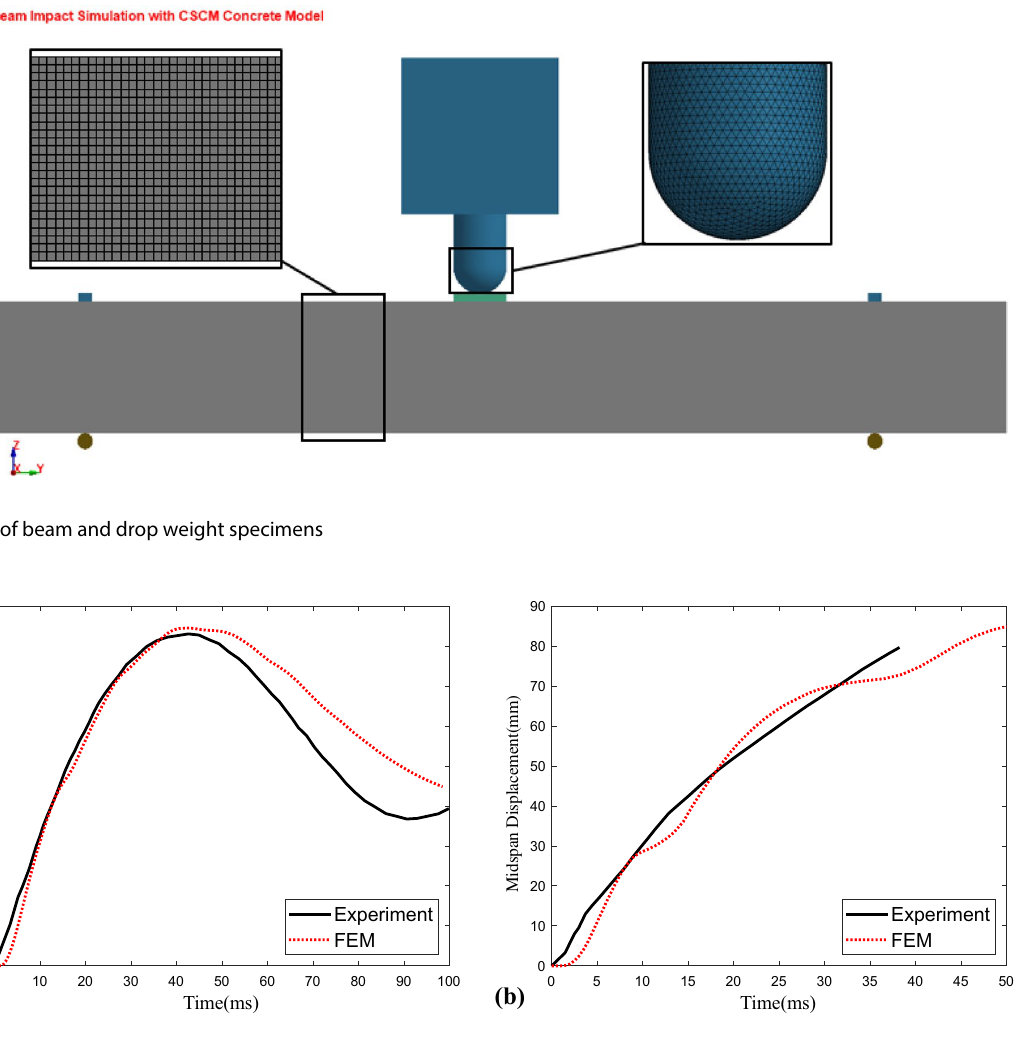
Fig. 5 Midspan deflection: a B-1700-4.6 and b